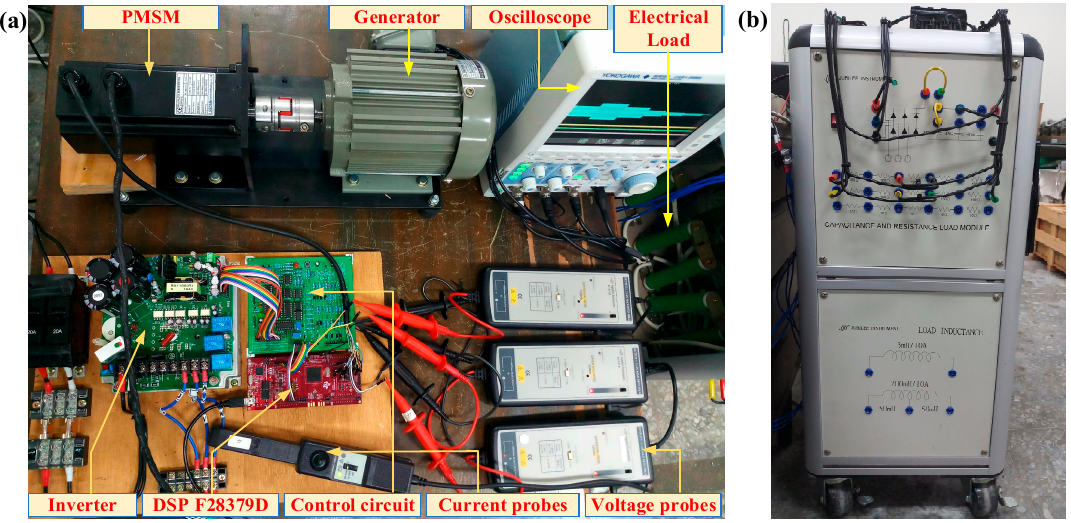
Figure 12. Experimental system with ( a ) real platform, ( b ) electrical load.